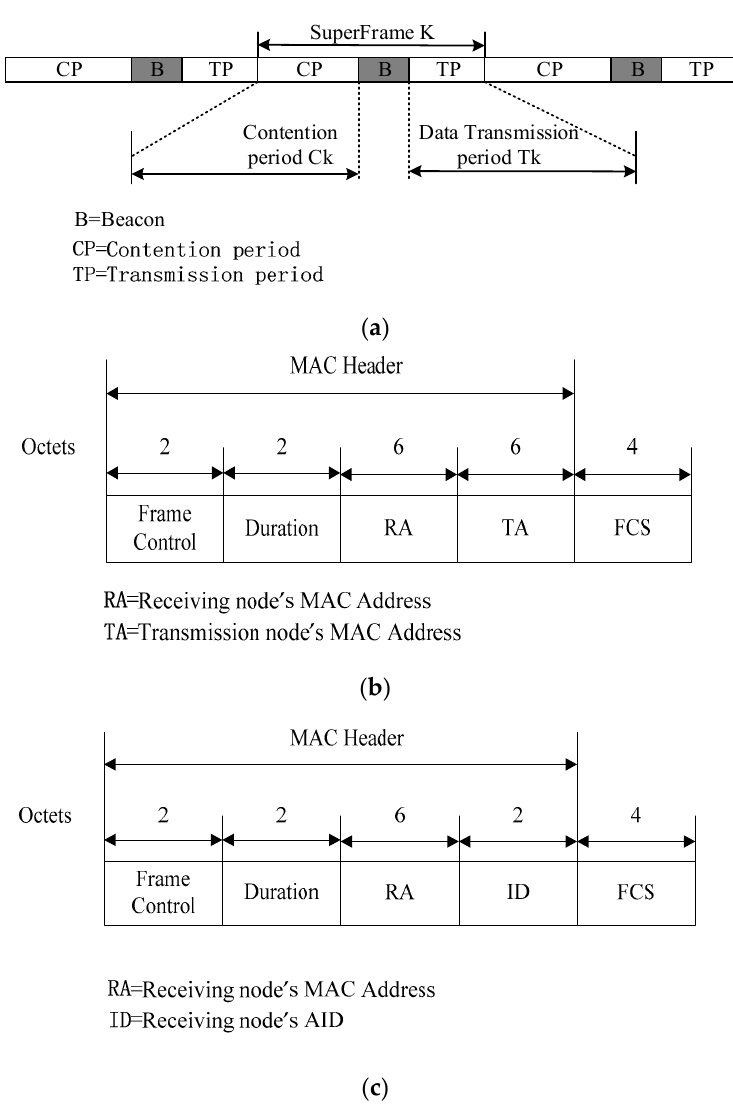
Figure 1. The format of super-frame, Data Transmission Request (DTR) and acknowledgement (ACK) frame. ( a ) superframe; ( b ) DTR frame; ( c ) ACK frame.